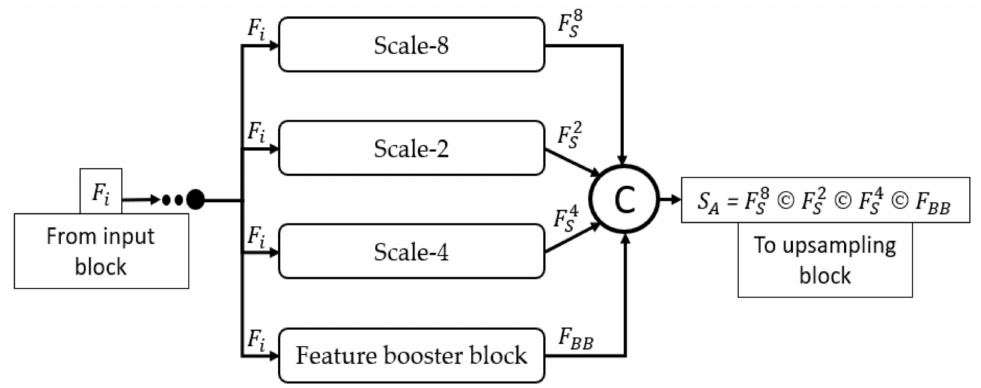
Figure 4. Dense connectivity pattern used in MASS-Net architecture for multiscale aggregation.